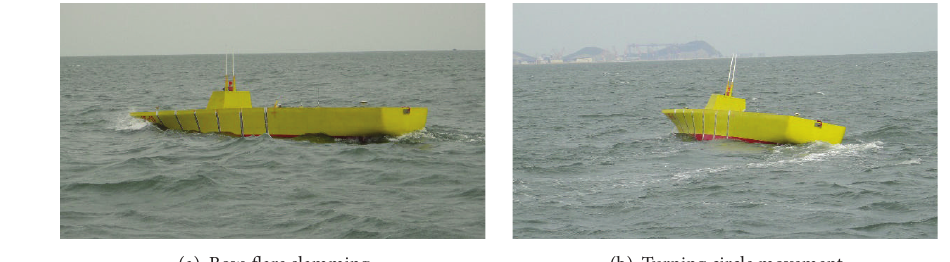
Figure 13: Snapshots of experimental